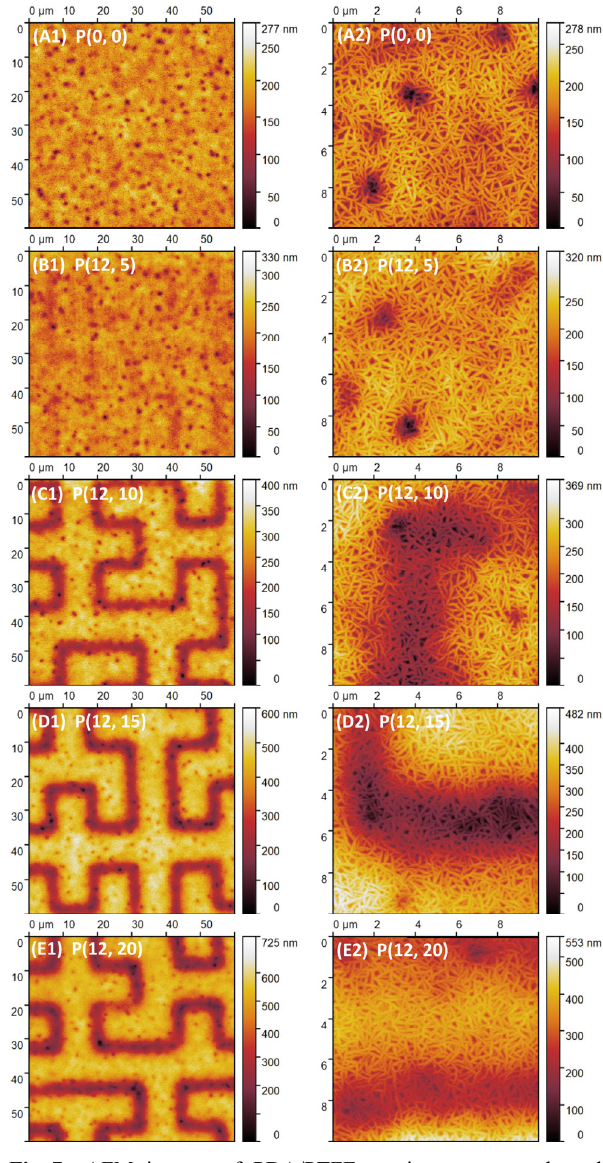
Fig. 7 AFM images of PDA/PTFE coatings on smooth and laser textured stainless steel with two scan sizes. The texture path segment length is 12 µm in all images and the laser power is: (A1) and (A2) 0, (B1) and (B2) 5%, (C1) and (C2) 10%, (D1) and (D2) 15%, and (E1) and (E2)